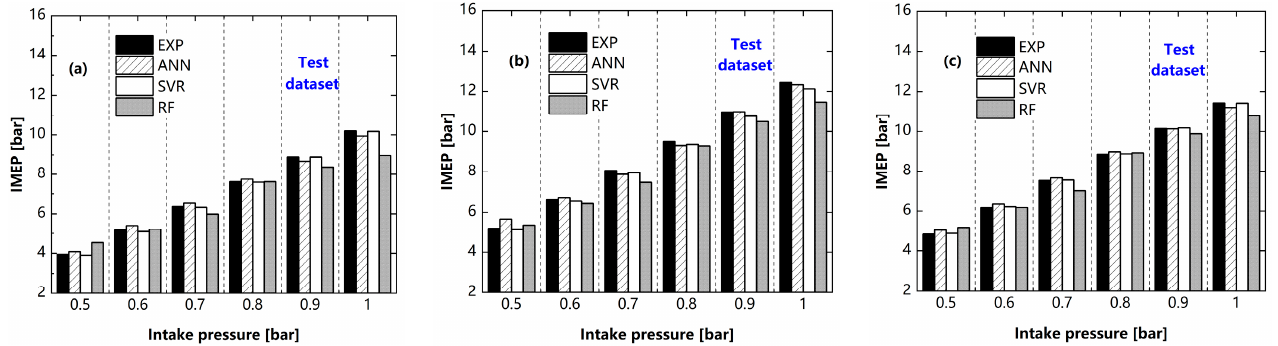
Figure 10. Comparison of predicted IMEP with actual values at MBT: ( a ) low load; ( b ) medium load; ( c ) high load.